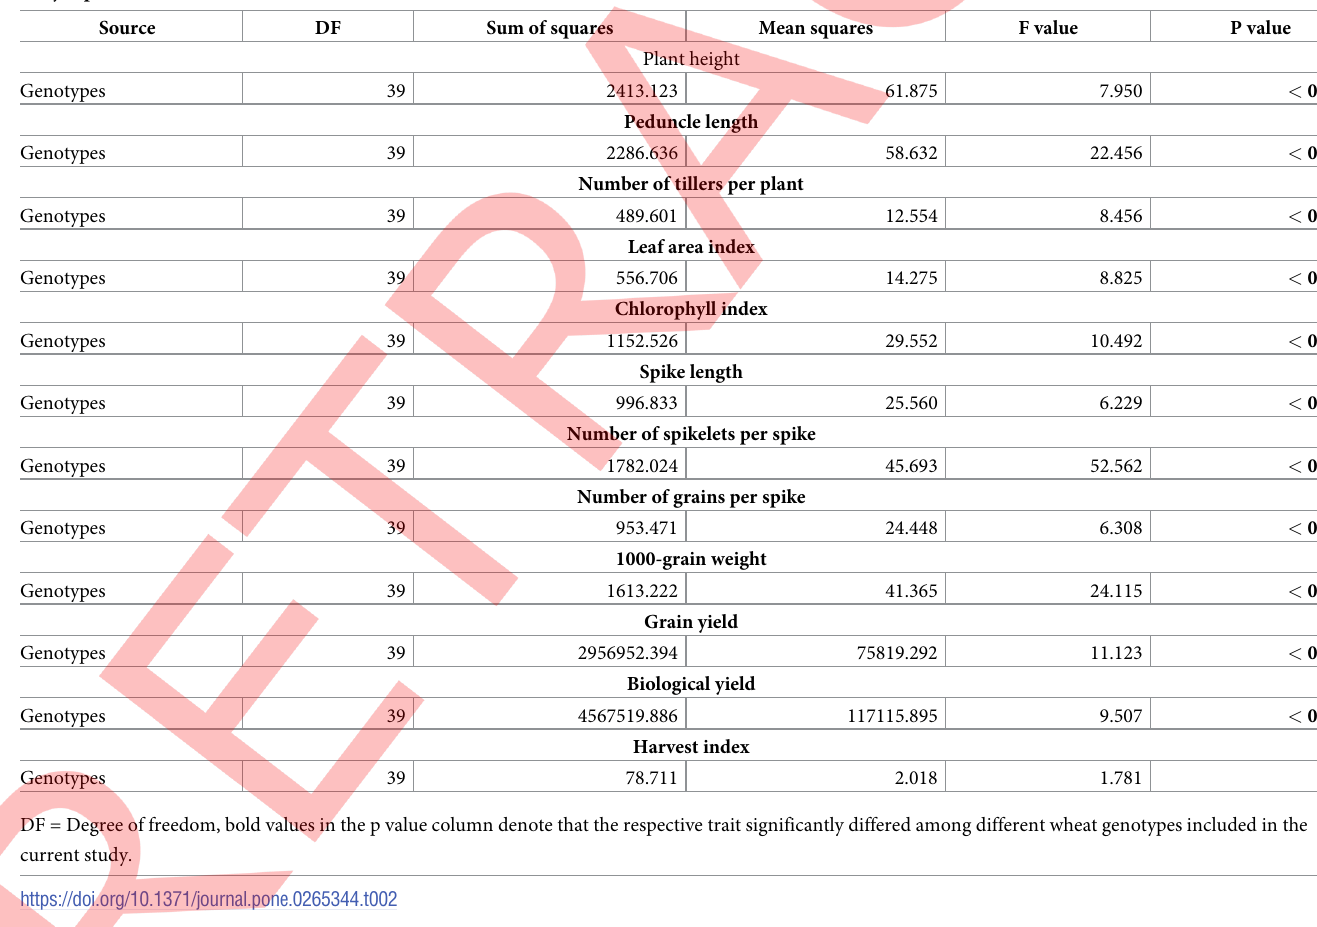
Table 2. Analysis of variance of different growth and yield-related traits of tested wheat genotypes sown under field conditions in three different districts of south Punjab province, Pakistan. Source DF Sum of squares Mean squares F value P value Plant